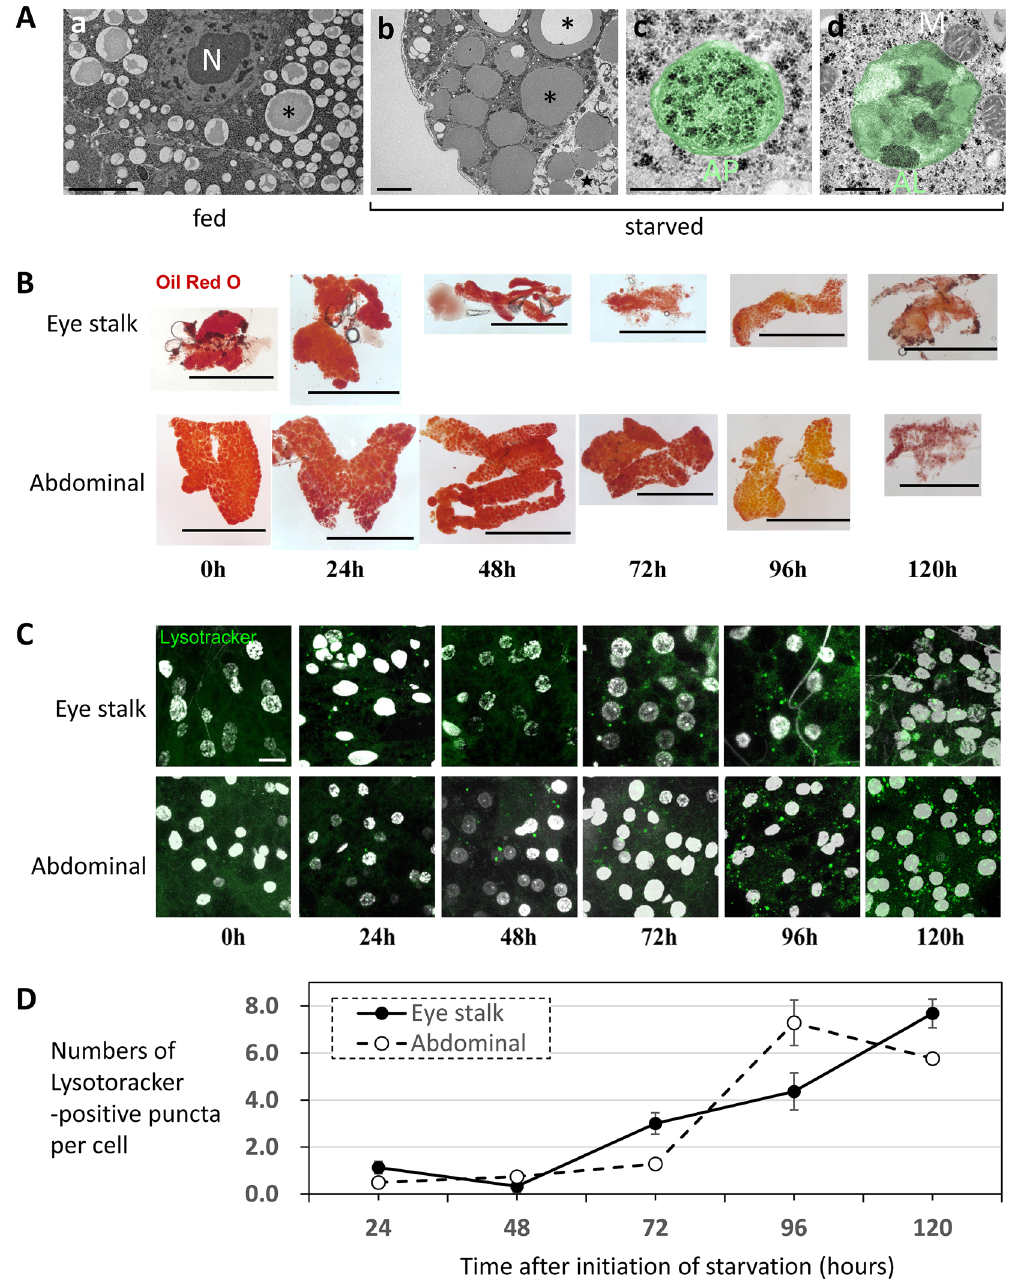
Figure 2. Fat body cells in the eye stalk and abdomen underwent equal autophagy of cytoplasmic components in response to starvation. ( A ) TEM of eye stalk fat body cells. (a) Cells derived from fed individuals. The electron-light lipid component was attached to the inner surface of the lipid droplet membrane in most cases (asterisk). N denotes the nucleus. (b–d) Cells derived from individuals starved for 48 h. (b) In lipid droplets, the electron-light lipid component is completely degraded or detached from the inner surface of the lipid droplet membrane (asterisks). Some cells show a clear cytoplasm (star), suggesting the occurrence of autophagic cell death. ( c ) A representative autophagosome (AP, highlighted with the green pseudocolor) containing glycogen granules that are normally present in the cytoplasm of fat body cells. (d) A representative autolysosome (AL, highlighted with the green pseudocolor) with a multilayered membrane containing organelle debris. A mitochondrion (M) is attached to the autolysosome. Scale bars: 5 μm (a,b), 0.5 μm (c,d). ( B ) Decrease in oil red O staining (brownish-red) in the fat bodies excised from the eye stalk and abdomen in response to starvation. Scale bars: 0.5 mm. ( C ) Increases in the numbers of lysosomes and autolysosomes (green puncta) stained with LysoTracker in fat body cells excised from the eye stalk and abdomen in response to starvation. Scale bar: 10 μm. ( D ) Time course of the number of LysoTracker-positive puncta per cell after the initiation of starvation. All of the data in ( A – D ) were derived from female S. detrahens . The times in ( B – D ) indicate hours after the initiation of